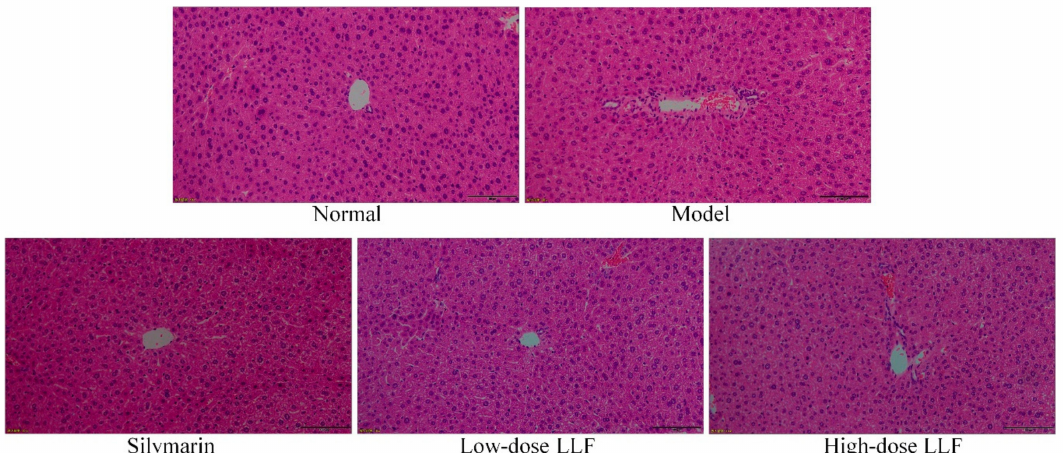
Figure 2. Hematoxylin and eosin (H and E) pathological observations of hepatic tissues in mice. Magnification 100 × . Silymarin: mice treated with silymarin (100 mg / kg); low-dose LLF: mice treated with a low concentration of lotus leaf flavonoids (50 mg / kg); high-dose LLF: mice treated with a high concentration of lotus leaf flavonoids (100 mg / kg).